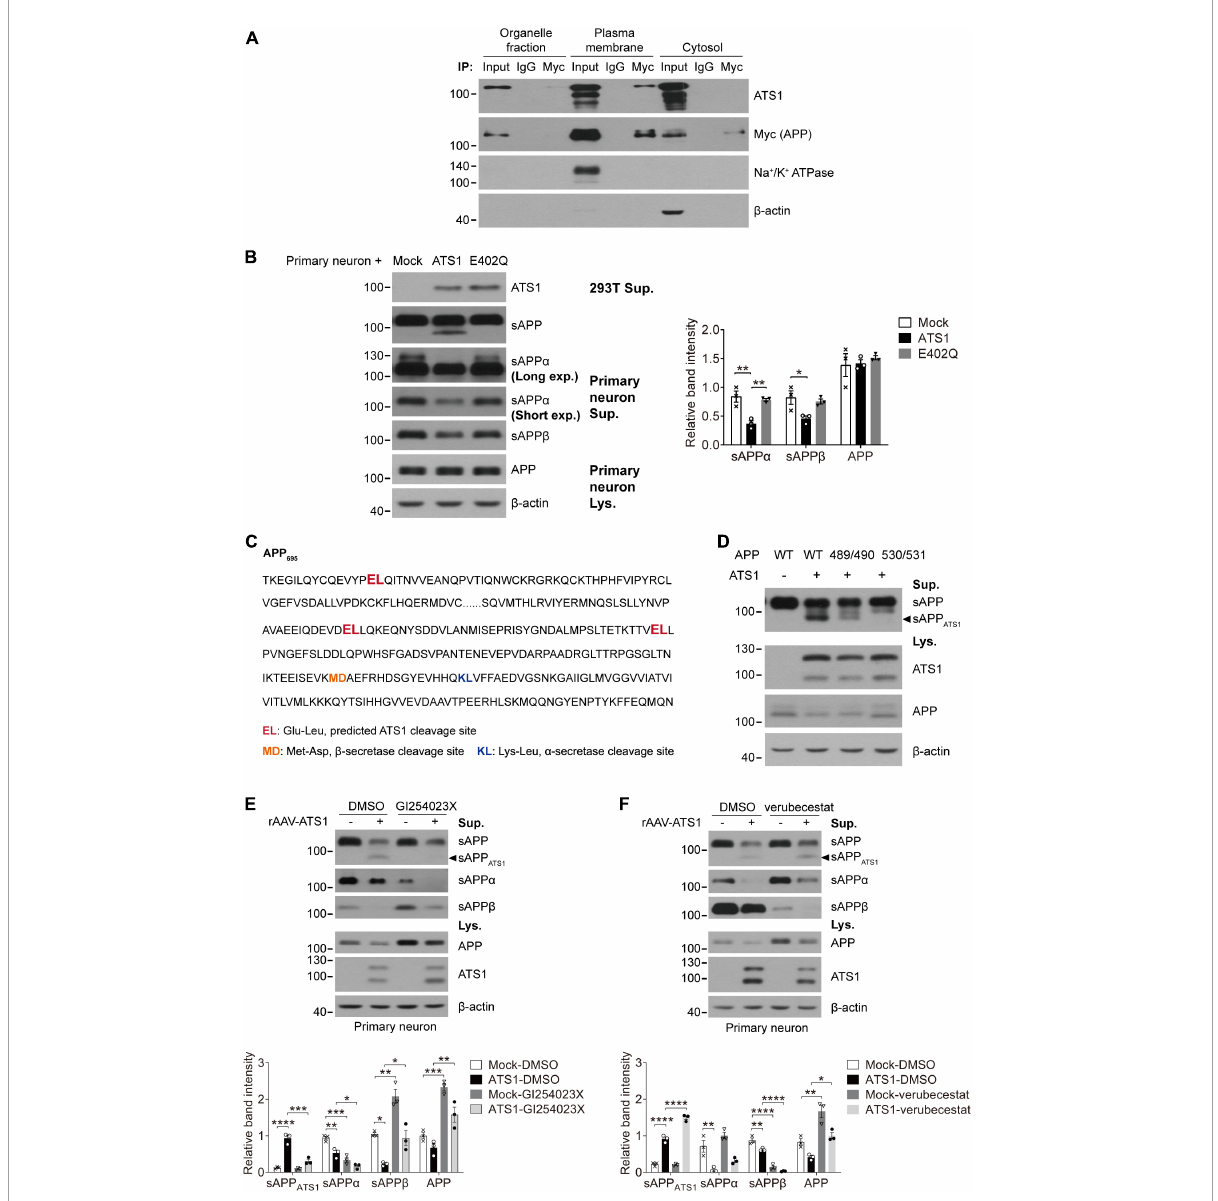
FIGURE5 ATS1 hydrolyzed APP in plasma membrane at E530/L531 site and competed with BACE1. (A) HEK 293T cells transfected with APP and ATS1 were subjected to cellular component separation and subsequent co-immunoprecipitation using Myc tag (APP) antibody. Western blot showed that the interaction of ATS1 and APP mainly occurred at the plasma membrane (labeled by Na + /K + ATPase). (B) Primary neurons were treated with conditioned medium from HEK 293T cells transfected with mock, ATS1 or E402Q mutant and subjected to western blot of APP pathway proteins sAPP, sAPP α , sAPP β , and APP. The relative band intensities of cleavage products were shown. Primary neurons exposed to the supernatant of ATS1 -transfected HEK 293T cell culture produced sAPP ATS 1 and exhibited reduced levels of conventional products when compared with mock control or E402Q -transfected group ( n = 3, sAPP α , P < 0.01, ATS1 vs. Mock, P < 0.01, E402Q vs. ATS1; sAPP β , P < 0.05, ATS1 vs. Mock, one-way ANOVA). Moreover, long exposure time resulted in the detection of endogenous sAPP α of HEK 293T cells with lower protein level but higher molecular weight. (C) Predicted ATS1 cleavage sites were shown (emphasized in red), and the latter two sites E489/L490 and E530/L531 within amino acids 420–580 of APP 695 were selected as the potential targets of ATS1. (D) HEK 293T cells were transfected with APP mutants holding A489/A490 or A530/A531. Western blot analysis showed that sAPP ATS 1 was erased in A530/A531 group. (E,F) Primary neurons infected with rAAV- ATS1 were treated with ADAM10 inhibitor GI254023X (20 µ M) or BACE1 inhibitor verubecestat (1 µ M) for 48 h. Western blot of APP pathway proteins (sAPP ATS 1 , sAPP α , sAPP β , and APP) was shown. The relative band intensities of sAPP ATS 1 revealed the potential competition between ATS1 and BACE1 [ (E) n = 3, sAPP ATS 1 , P < 0.001, ATS1-GI254023X vs. ATS1-DMSO, one-way ANOVA; (F) n = 3, sAPP ATS 1 , P < 0.0001, ATS1-verubecestat vs. ATS1-DMSO, one-way ANOVA]. * P < 0.05, ** P < 0.01, *** P < 0.001, **** P < 0.0001. Data were expressed as Mean ± SEM. ATS1, ADAMTS1; IP, immunoprecipitation; Lys., lysates; Sup., supernatant; Mock, empty vector; Long exp., long exposure time; Short exp., short exposure time; WT, wild type; 489/490, A489/A490; 530/531,